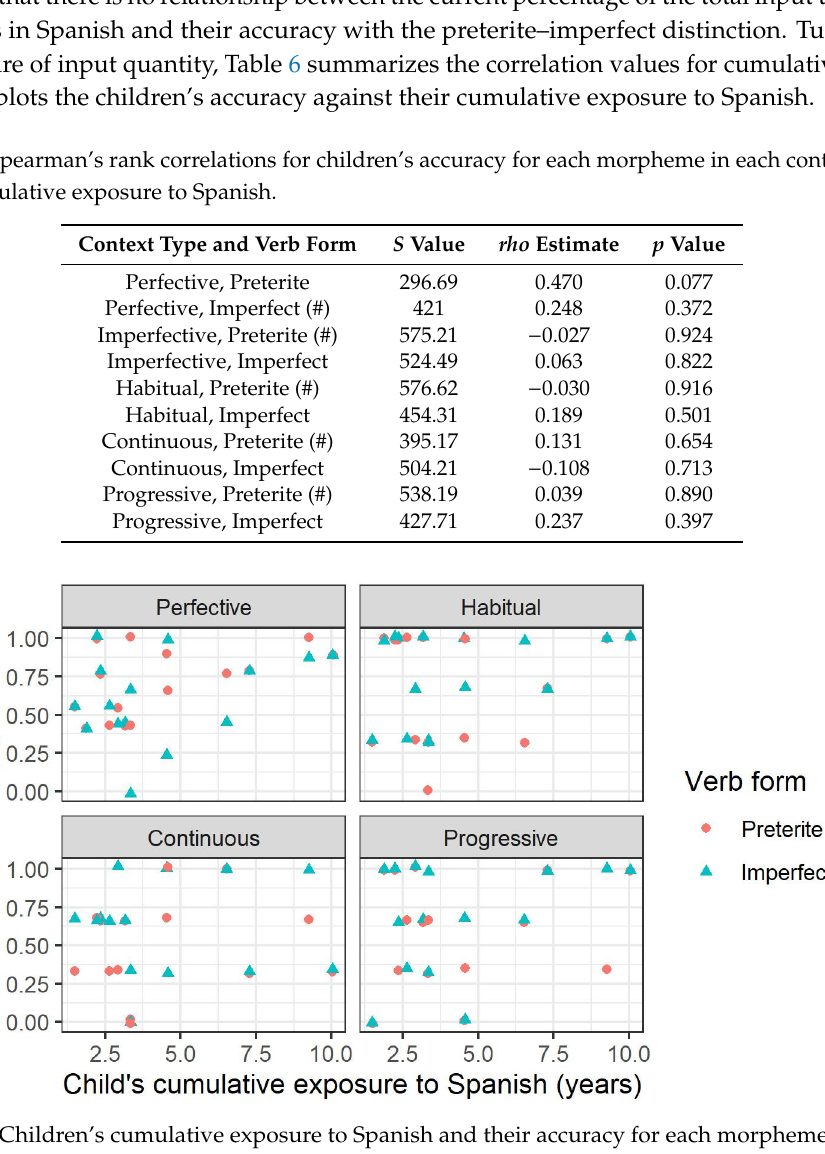
Figure 4. Children’s cumulative exposure to Spanish and their accuracy for each morpheme in four contexts (perfective, habitual, continuous and